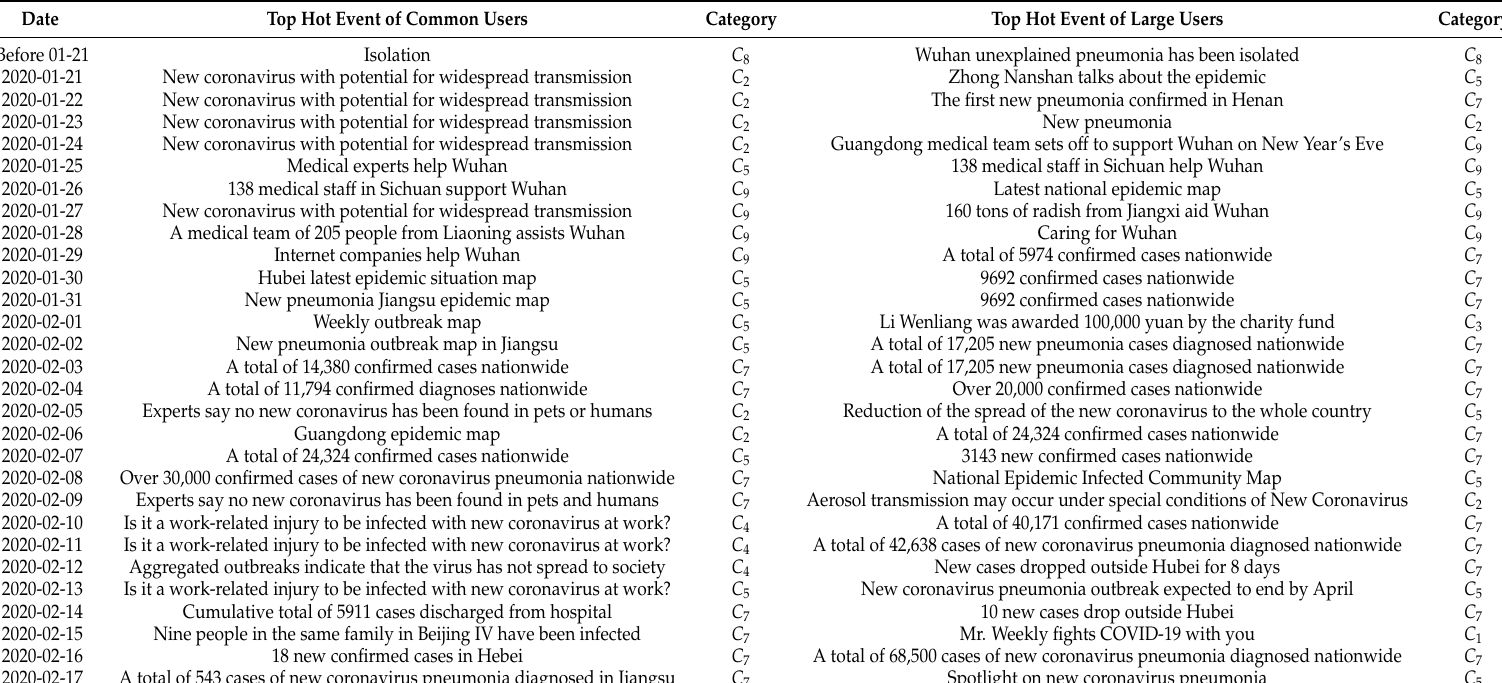
Table A1. Top hot events among large users and common users on the microblog